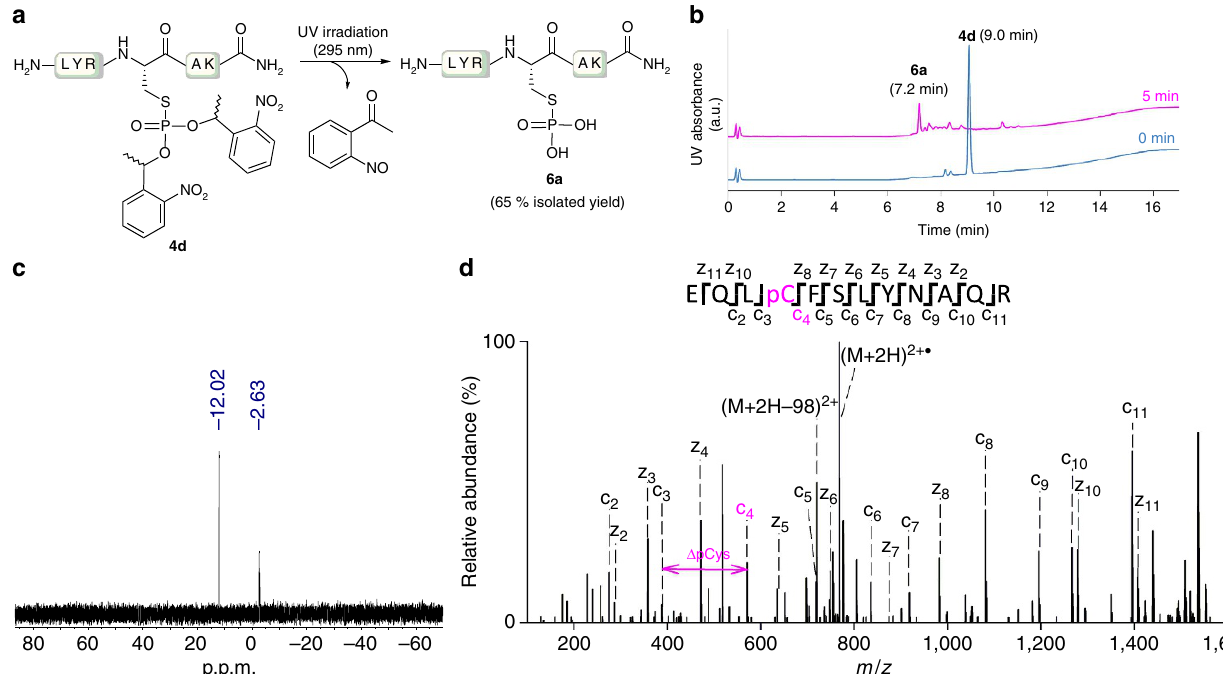
Figure 3 | Ultraviolet-deprotection and analytical characterization of pCys peptide 6a and 6b. ( a ) Light-induced photolysis of peptide 4d to deliver pCys peptide 6a in 65% isolated yield. ( b ) UPLC-UV traces before (in blue) and directly after ultraviolet light exposure (in magenta). ( c ) 31 P-NMR experiment showing the characteristic peak for pCys residues (12.02p.p.m.) and inorganic phosphate. ( d ) EThcD MS/MS spectra of pCys peptide 6b , showing complete sequence coverage and diagnostic fragment ions c4, and z10. a.u., arbitrary unit.